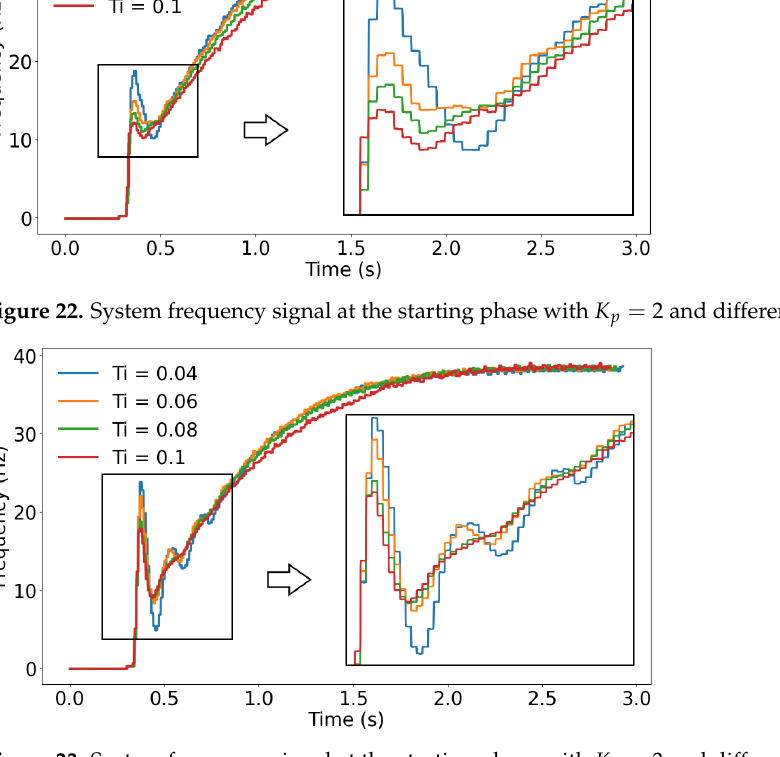
Figure 23. System frequency signal at the starting phase with K p = 3 and different T i